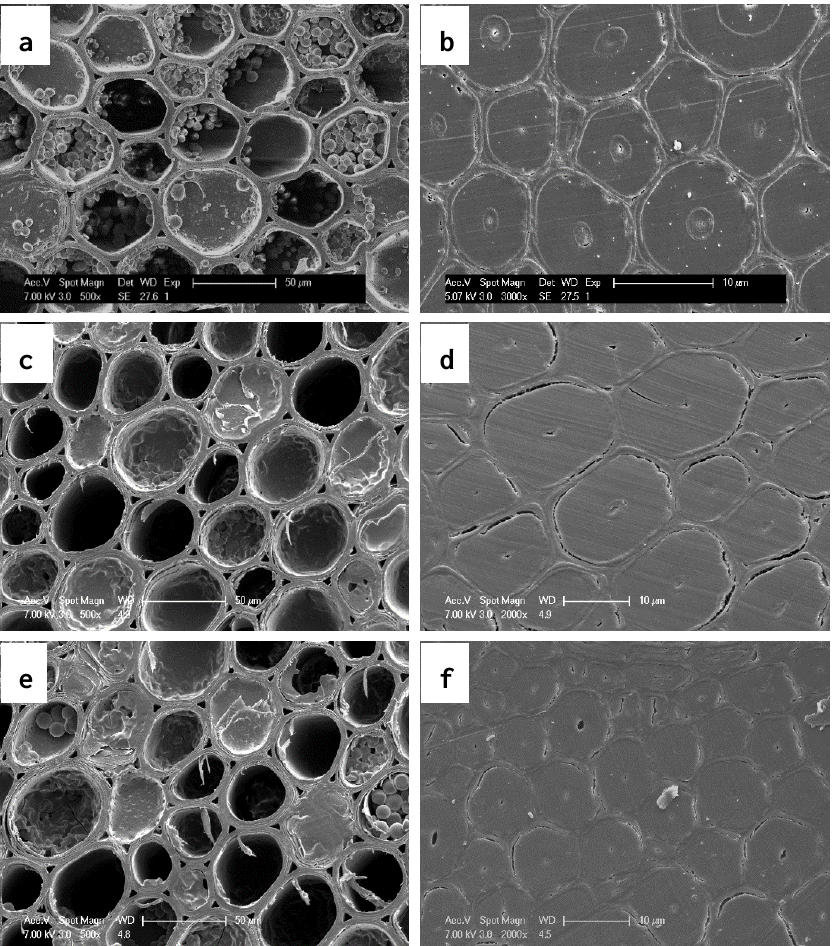
Figure 3. SEM micrographs of microtomed cross-sections: ( a ) the parenchymal cells of untreated bamboo; ( b ) the fibers of untreated bamboo; ( c ) the parenchymal cells near the surface of the furfurylated bamboo; ( d ) the fibers near the surface of the furfurylated bamboo; ( e ) the parenchymal cells close to the center of the furfurylated bamboo; ( f ) the fibers close to the center of the surface of the furfurylated bamboo.